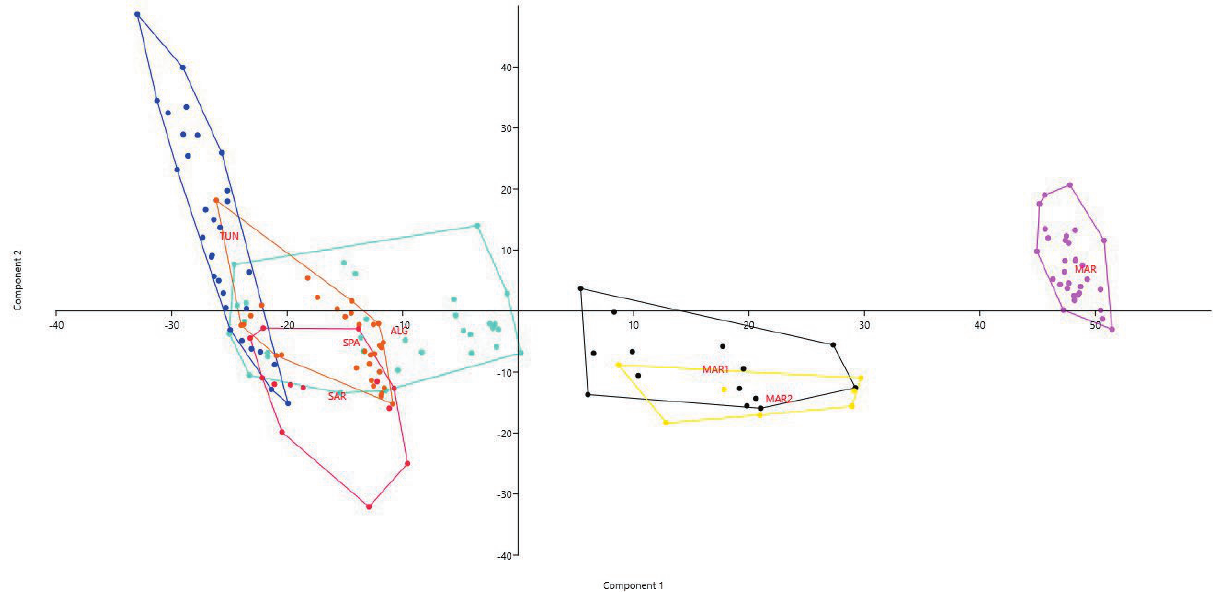
Figure 2. Principal components analysis based on the 12 considered morphological characters, with 7 a priori defined groups based on the geographical distribution of the sampled populations. PC1 Eigenvalue 645.724, % variance 76.48, PC2 Eigenvalue 132.387, % variance